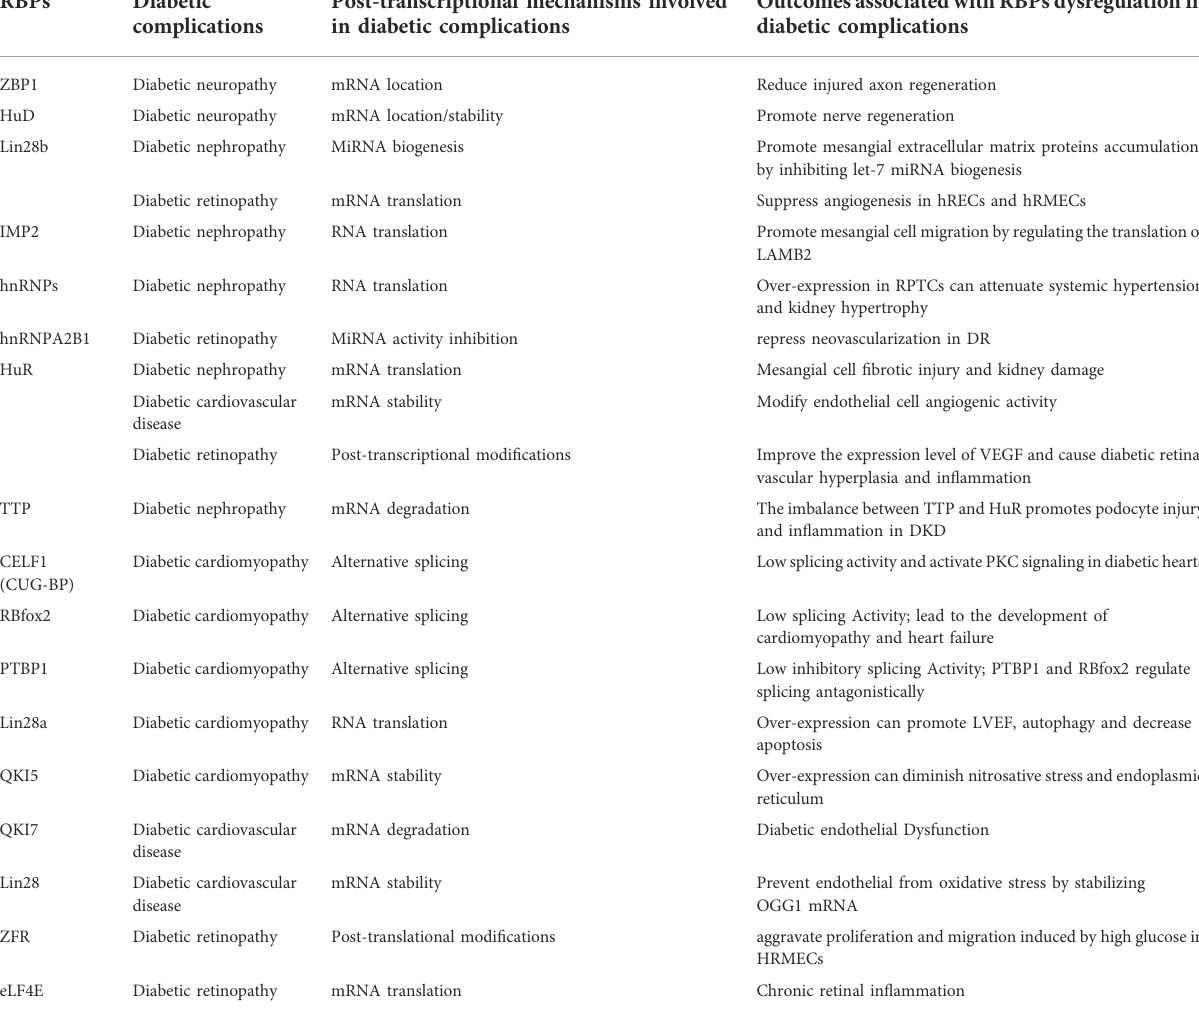
TABLE 1 The regulatory mechanism of RNA-Binding proteins and the outcomes of their dysregulation in diabetic